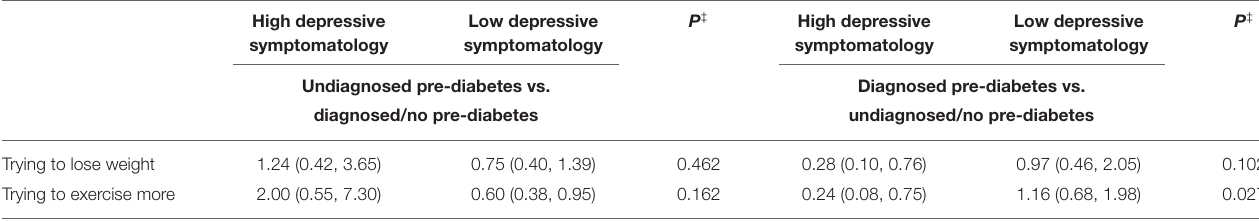
TABLE 2 | Unadjusted odds ratios and 95% confidence intervals for the associations between pre-diabetes and trying to complete lifestyle changes after a doctor’s recommendation stratified by depressive symptomatology. High depressive